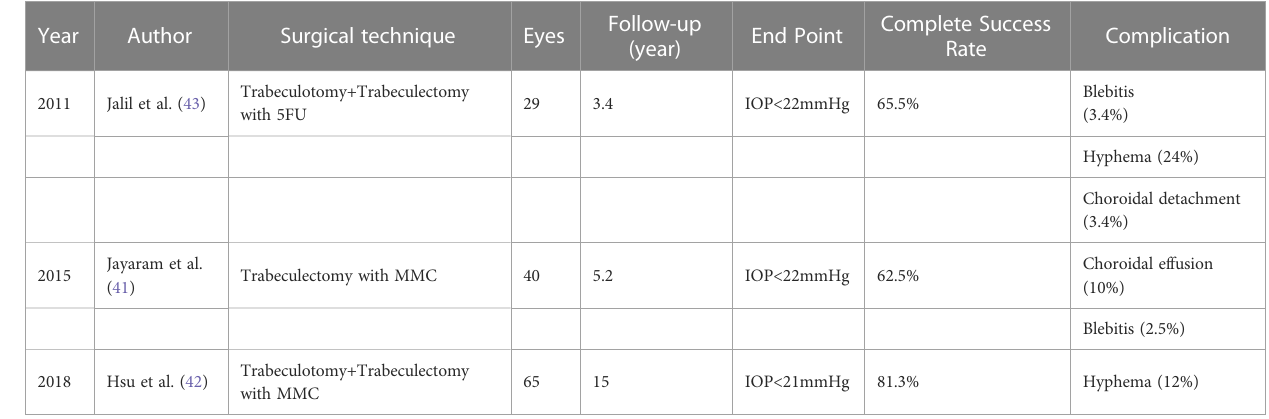
TABLE 4 Summary of trabeculectomy in childhood glaucoma.